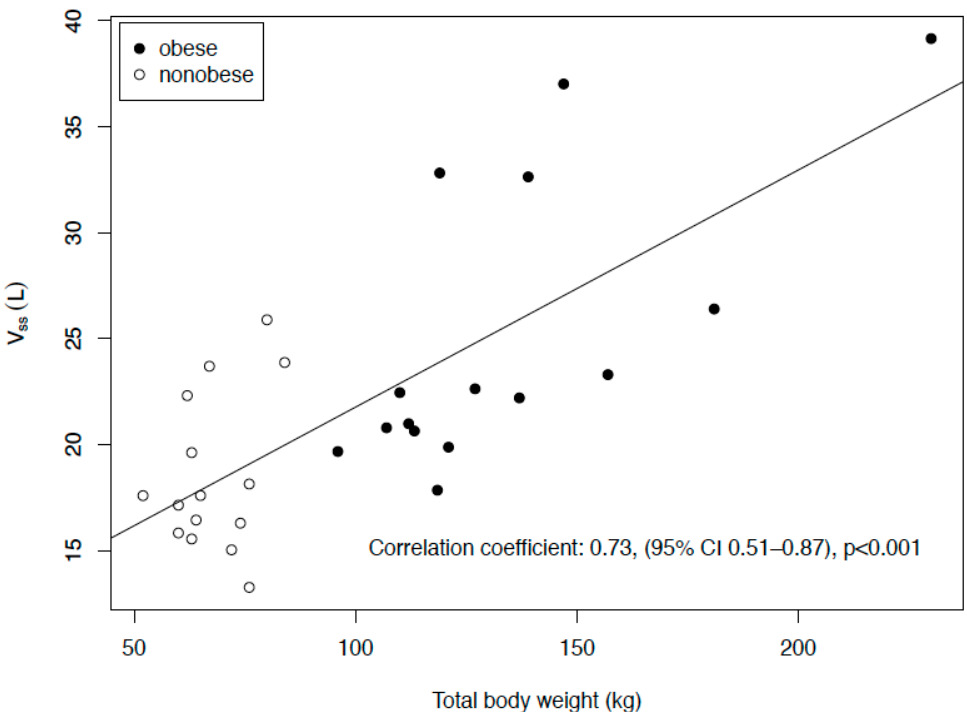
Figure 3. Correlation of the volume of distribution at the steady state (Vss) with the total body weight. Table 3. Time (in hours) for which the concentration is above the minimum inhibitory concentration (MIC) (T > MIC).